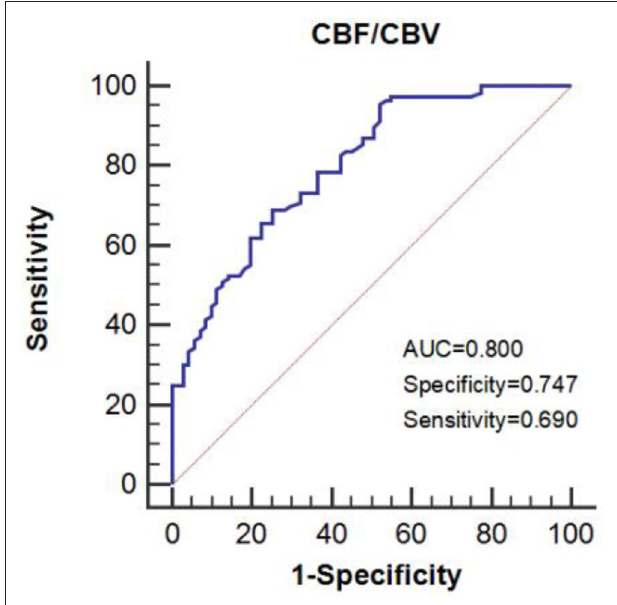
FIGURE 4 | The area under the receiver operating characteristic (ROC) curve predicts impaired perfusion in patients with symptomatic ICA steno-occlusive disease.